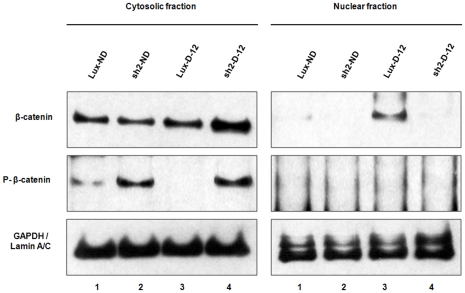
Western blot analysis of total and phosphorylated β-catenin in wild type and HPRT knockdown cells.Undifferentiated control cells transduced with a control luciferase vector (lane 1), undifferentiated cells transduced with the HPRT knockdown vector (2), luciferase-transduced cells at 12 days of differentiation (3) and HPRT-knockdown differentiated cells at 12 days of differentiation (4). Bottom panels represent GAPDH and lamin loading controls.